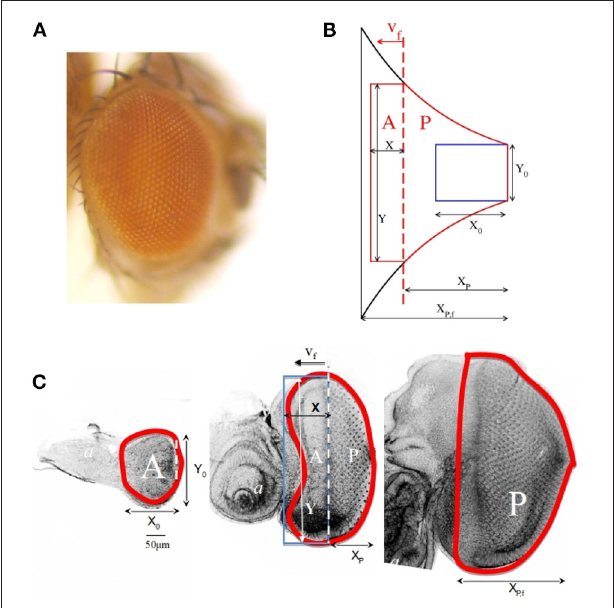
FIGURE 1 | (A) Adult eye in Drosophila melanogaster . (B) Schematic representation of the shape of the eye according to the theoretical model. The blue rectangle corresponds to the primordium shape at t = 0. The black contour represents the final shape of the eye. The red curve is the shape of the eye at an intermediate stage. (C) Eye imaginal discs from early (left), mid (middle) and final (right) third larval stage, stained with Rhodamine-Phalloidin, to mark cell contours, and imaged using a Leica SPE confocal set up. Images were processed with Adobe Photoshop. In these figures X 0 and Y 0 correspond to the initial dimensions of the primordium. The morphogenetic furrow (MF) is represented as a vertical red dashed line that separates the anterior A from the posterior P region and it moves with speed v f . The instantaneous and final posterior-to-anterior dimensions of P area, X P and X P , f , as well as the instantaneous dimension of A , X , and Y , are also represented in the